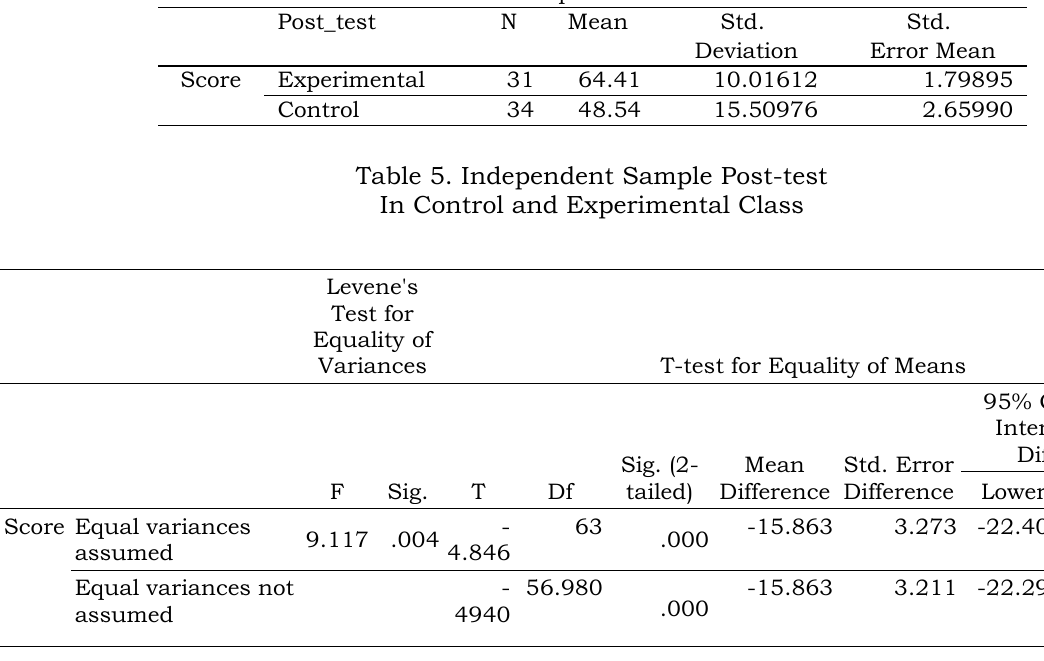
Table 4. The result of post-test